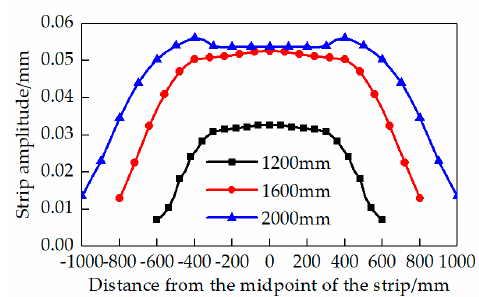
Figure 14. Amplitude distribution of different widths.